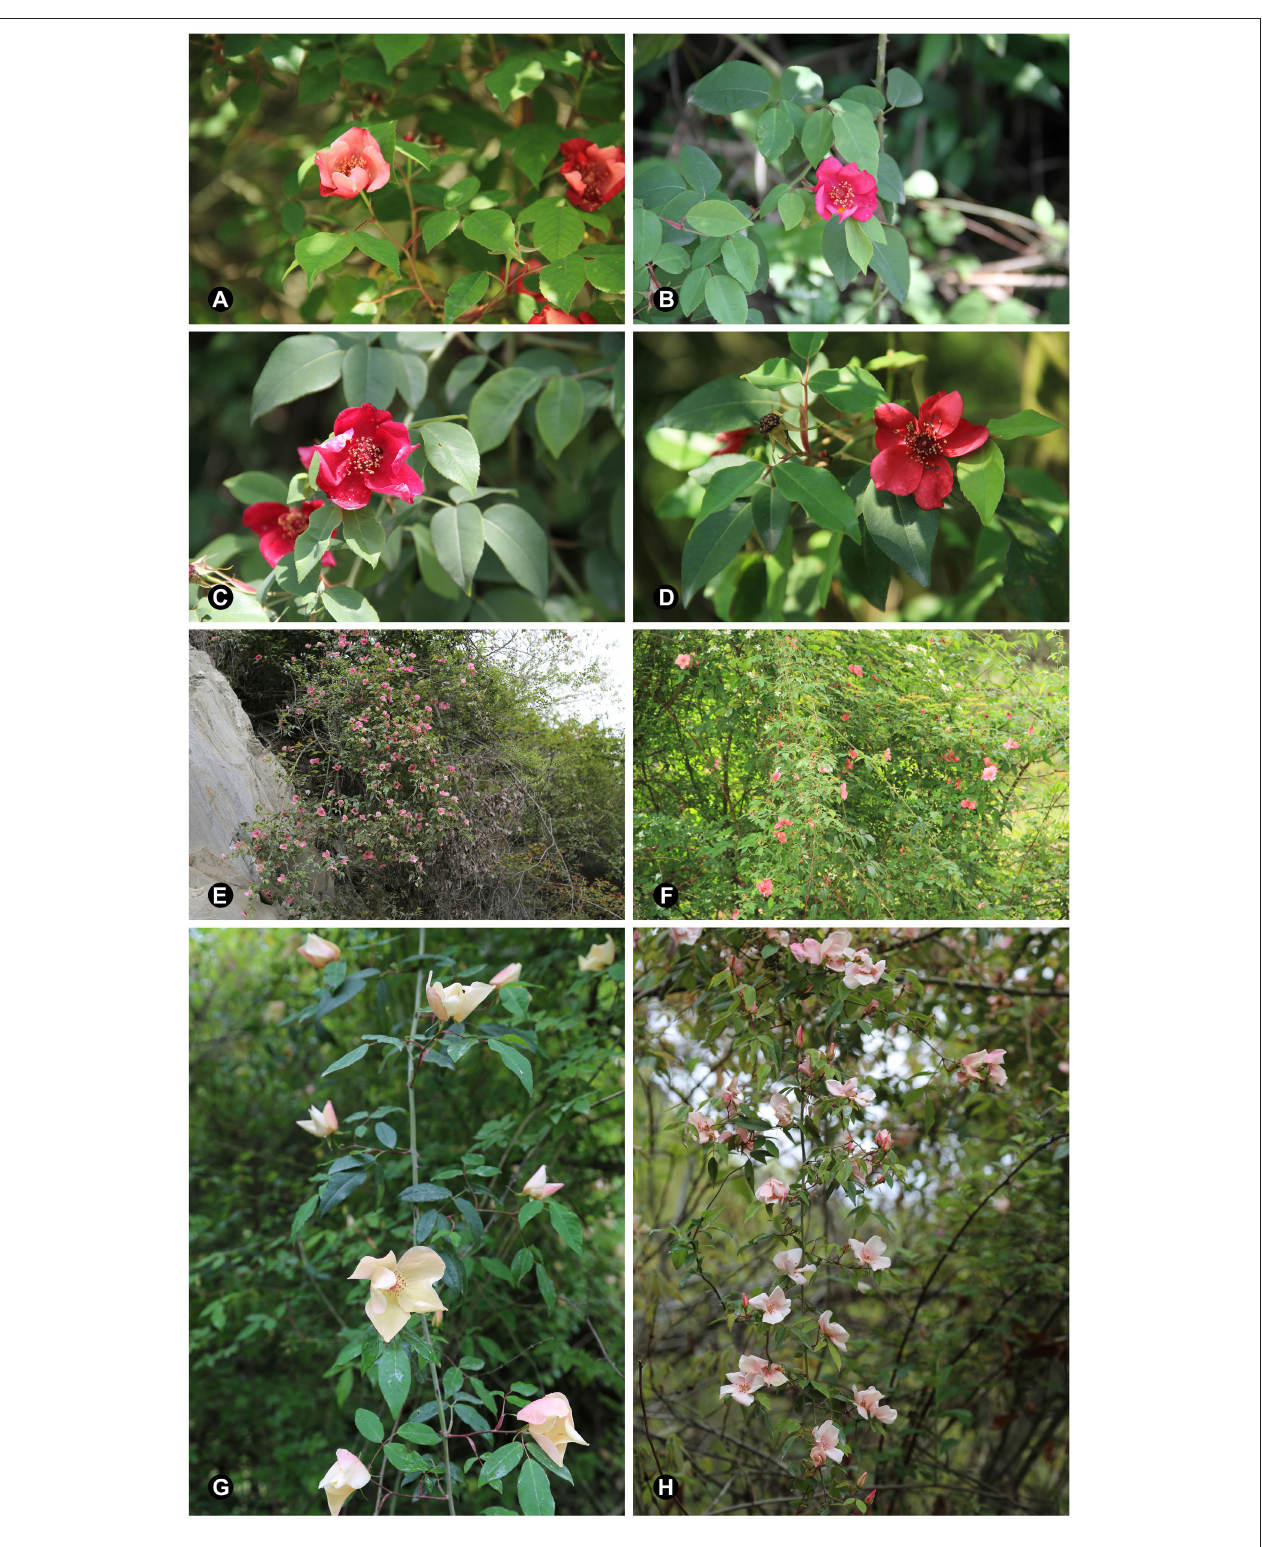
FIGURE 2 | Change of petal color different opening stage and morphological variation within population MX. (A) Initial blooming stage. (B) Full-blooming stage. (C) Post-blooming stage. (D) Wither stage. (E) Individuals with pink flowers. (F) Individuals with crimson flowers. (G) Individuals with creamy white flowers. (H) Individuals with pinkish-white